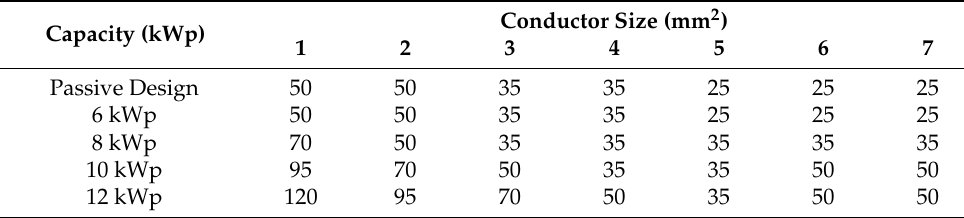
Table 6. Conductor sizes for different DER